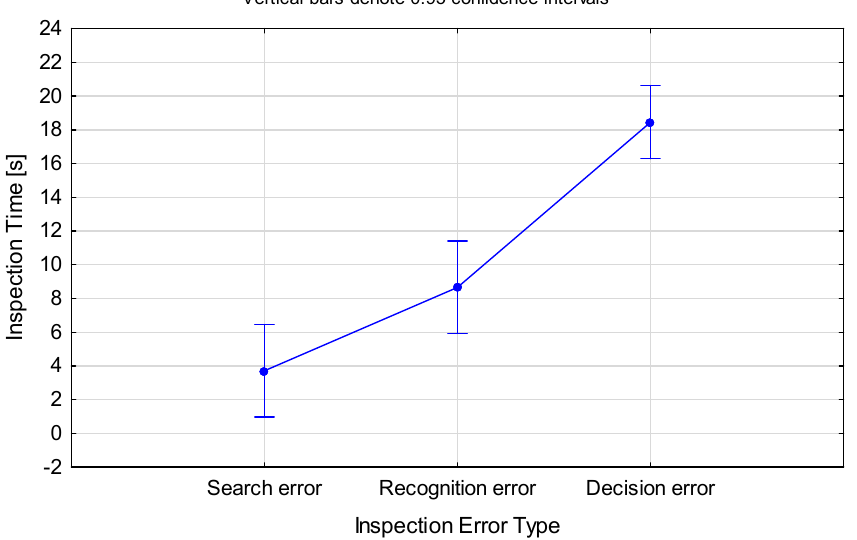
Figure 21. Correlation between inspection time and inspection error. Table 7. Statistical model around the inspection time (Wald test and parameter estimates).